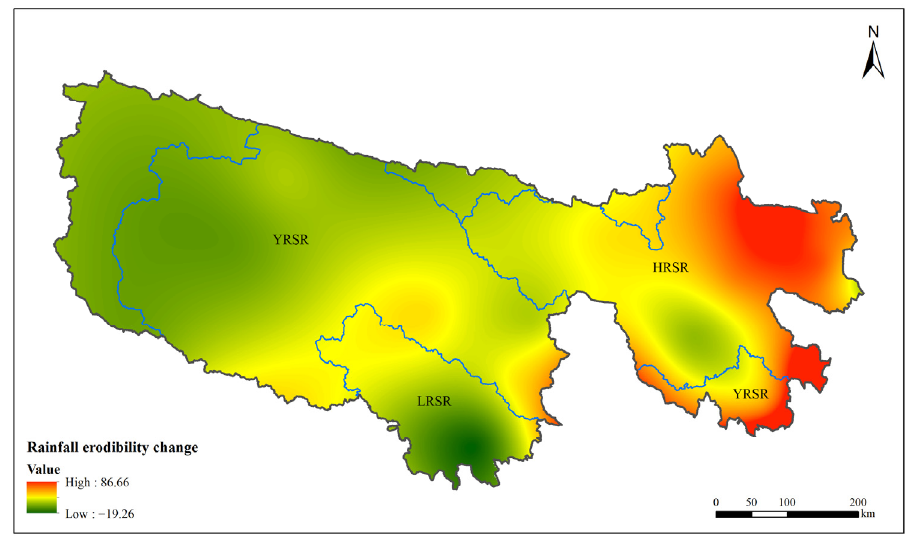
Figure 5. Spatial distribution of rainfall erodibility changes from 2000 to 2020 in the TRHR, China.